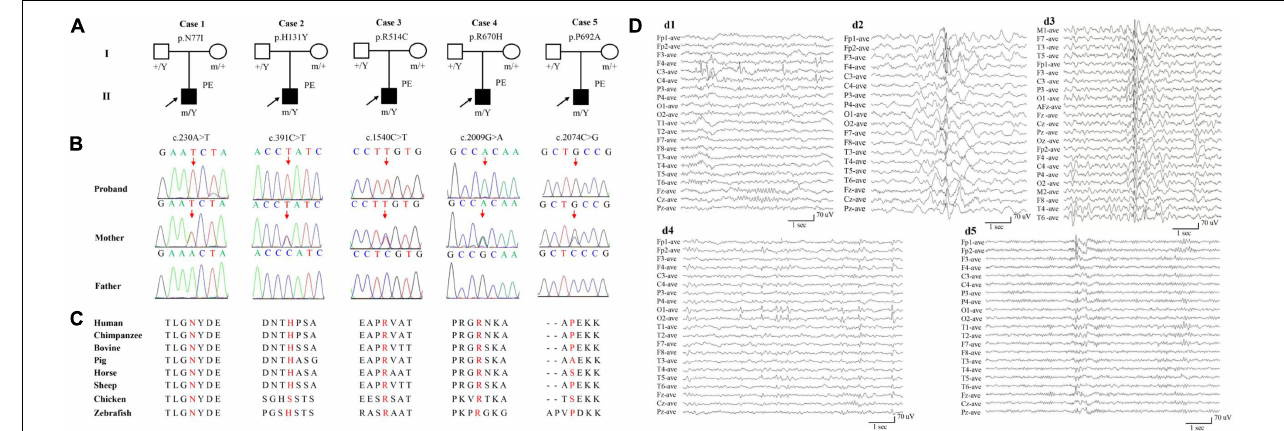
FIGURE 1 | Genetic and electroencephalograms (EEG) of the cases with AFF2 mutations. (A) Pedigrees of the five cases with AFF2 mutations and their corresponding phenotypes. PE, partial epilepsy. (B) DNA sequence chromatogram of the AFF2 mutations. Arrows indicate the positions of the mutations. (C) The amino acid sequence alignment of the five missense mutations shows that residues N77I, R514C, and R670H were highly conserved across various species. Residues H131Y and P692A were less conserved. (D) Changes of interictal EEG in the cases with AFF2 mutations. (d1) Interictal EEG of case 1 showed bilateral frontal-central spike and slow waves (obtained at the age of 8 years). (d2) Interictal EEG of case 2 showed bilateral frontal and anterior-temporal spike and slow waves (at the age of 9 years). (d3) Interictal EEG of case 3 showed spike and slow waves predominant at left hemisphere (at the age of 5 years). (d4) Interictal EEG of case 4 showed sharp waves predominant at bilateral occipital regions (at the age of 3 years). (d5) Interictal EEG of case 5 showed spike and slow waves predominant at bilateral frontal regions (at the age of 17